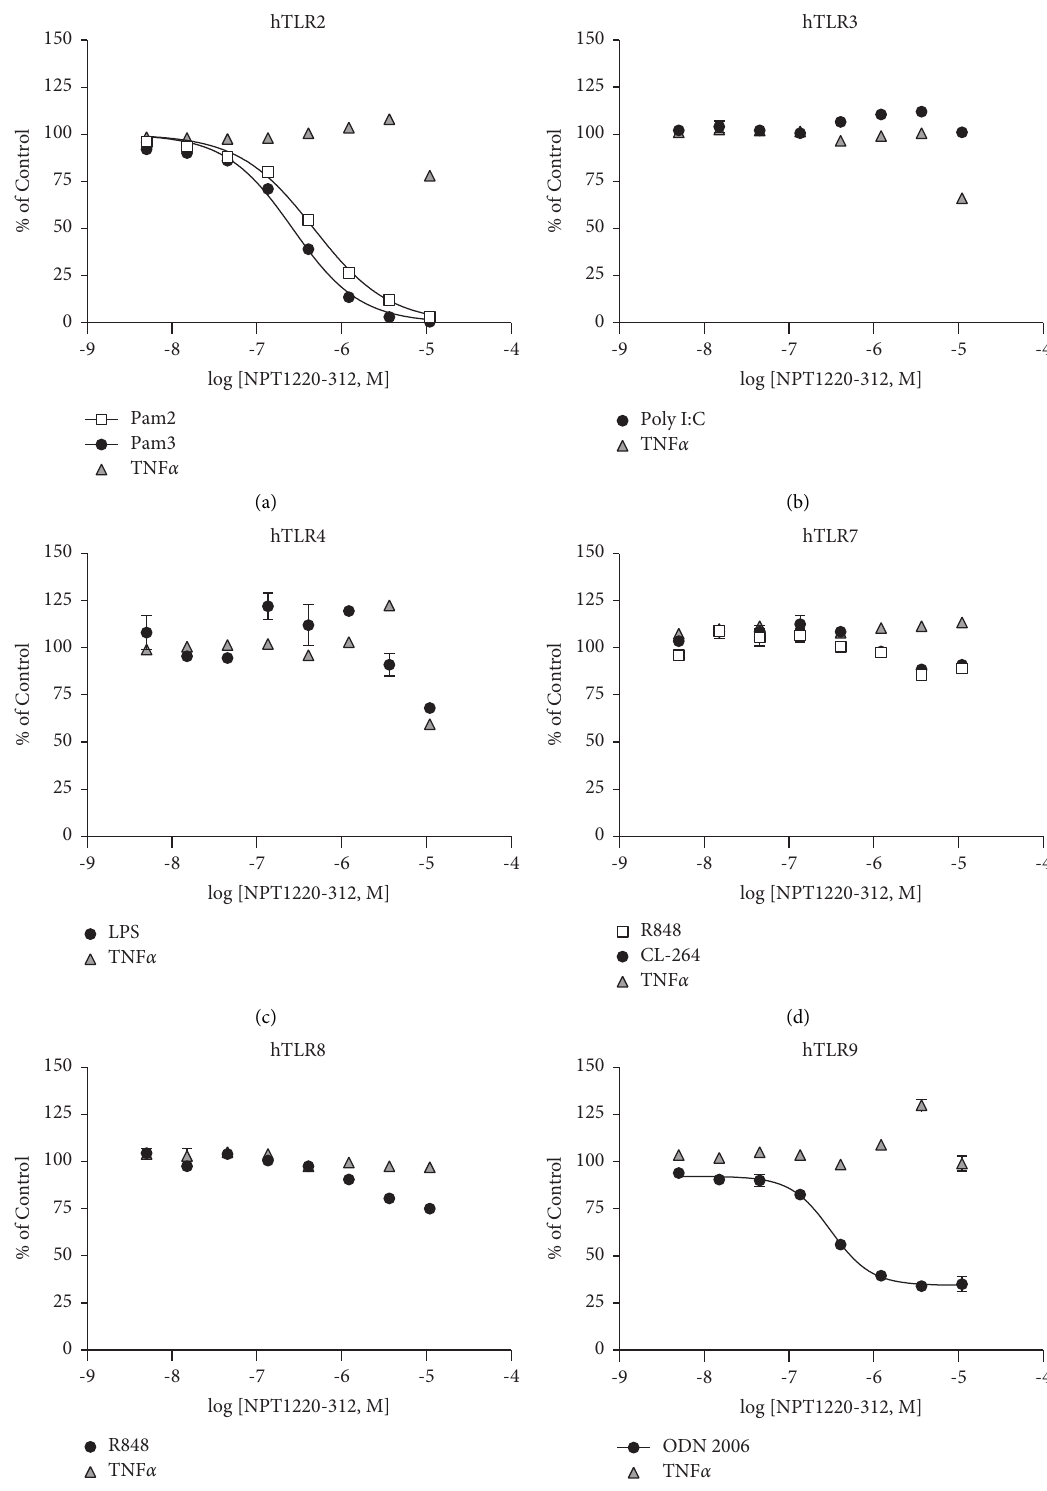
Figure 1: NPT1220-312 selectively inhibits TLR2 and TLR9. NPT1220-312 inhibition of (a) TLR1/2 as activated by Pam as activated by Pam 2 CSK 4 in HEK293 cells overexpressing hTLR2; (b) TLR3 as activated by Poly I:C in HEK293 cells overexpressing hTLR3; (c) TLR4 as activated by LPS in HEK293 cells overexpressing hTLR4; (d) TLR7 as activated by R848 and as activated by CL-264 in HEK293 cells overexpressing hTLR7; (e) TLR8 as activated by R848 in HEK293 cells overexpressing hTLR8; and (f) TLR9 as activated by